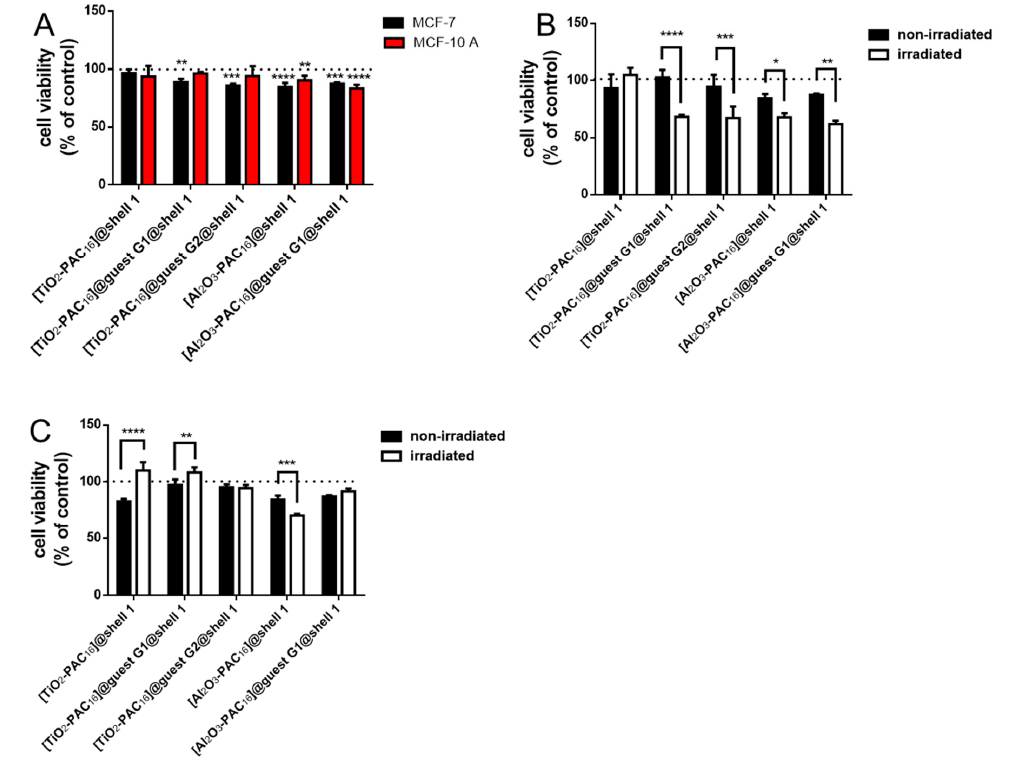
Figure 6. Biocompatibility of the nanocarriers for MCF-7 and MCF-10 A cells ( A ), cell viability in nanocarriers loaded MCF-7 ( B ) and MCF-10 A ( C ) cells before and after irradiation with a single dose of 1 Gy, n = 6, *: p < 0.05, **: p < 0.01, ***: p < 0.001,****: p < 0.0001.